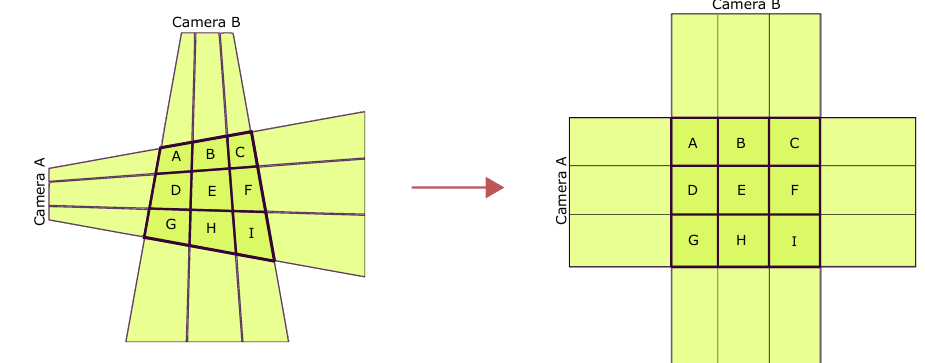
Figure 1. The left panel shows an exaggerated cartoon of a top-down view of the 2DVD measurement area geometry; for simplicity, the intersection of the cameras is shown as if each line scan camera is composed of only 3 pixels, whereas the line scan cameras in an actual 2DVD have 632 pixels on a side. The right panel shows a remapping of this measurement region (which is actually the intersection of two trapezoids) into a regular square grid. Though the square grid is more convenient for visualization, note that the true areas of pixels A and I are physically different when accounting for the real optical geometry (which becomes relevant when determining the drop size-dependent effective sample